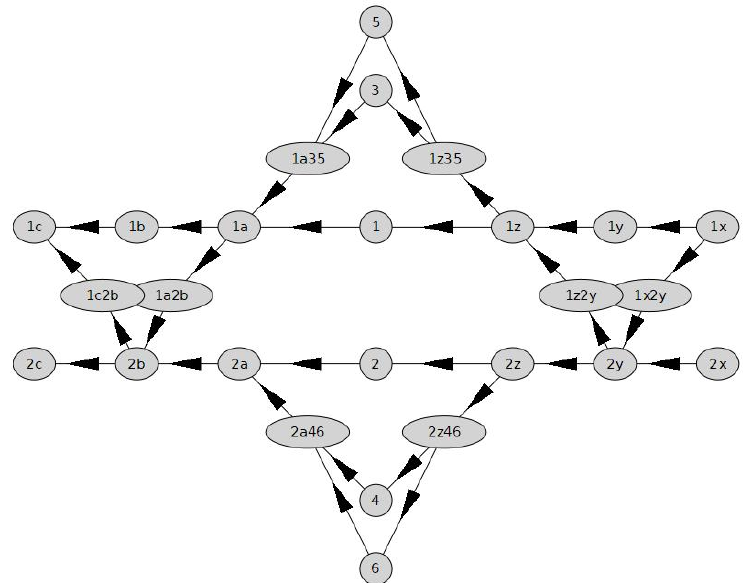
Figure 9. The track layout diagram of Figure 4 divided into sections. Considering vertices 1c2b , 1a2b , 1z2y , and 1x2y is not strictly necessary; however, they were considered in [16] in order to closely resemble the connectivity of the turnouts.